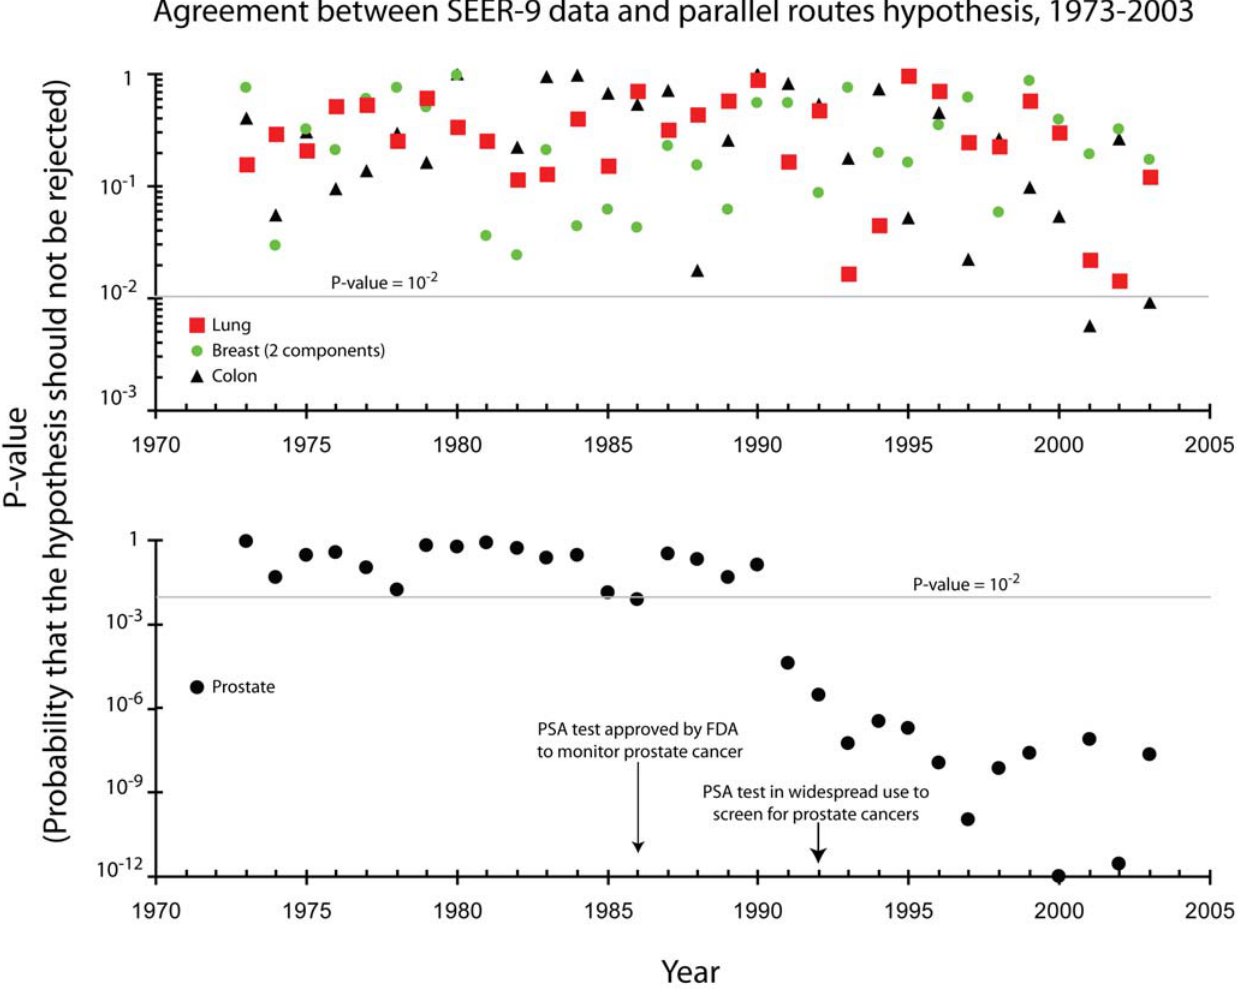
Figure 2. This graph quantitatively shows the agreement between the SEER-9 data and the hypotheses (Equations 3 and 4). The top panel displays the agreement, as measured by a p-value, between lung and colon carcinoma and Equation 3, and between breast carcinoma and Equation 4. In all cases the p-value, representing the probability that one should accept the hypothesis, is greater than 0.001, and in most cases it exceeds 0.01. In contrast, the corresponding graph for prostate carcinoma and Equation 3 shows that the p-value always exceeded 0.01, until 1991 when it plunged below that level. Prostate carcinoma, post 1991, clearly cannot be explained by Equation 3, but it is in agreement with Equation 4. The 1991 change corresponds to the widespread implementation of screening for prostate carcinoma using the PSA